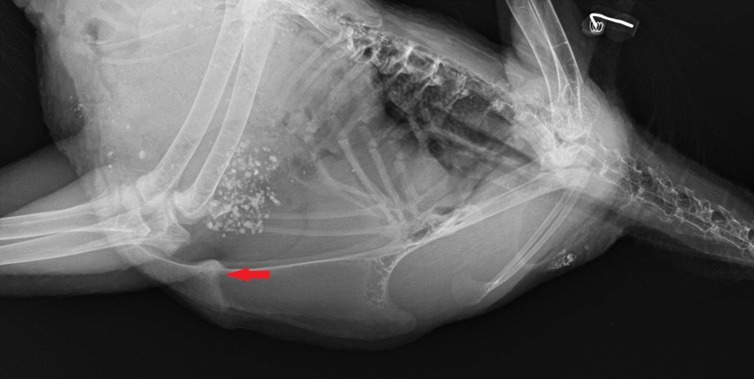
A fractured keel bone with callus formation.The arrow shows the fracture callus.